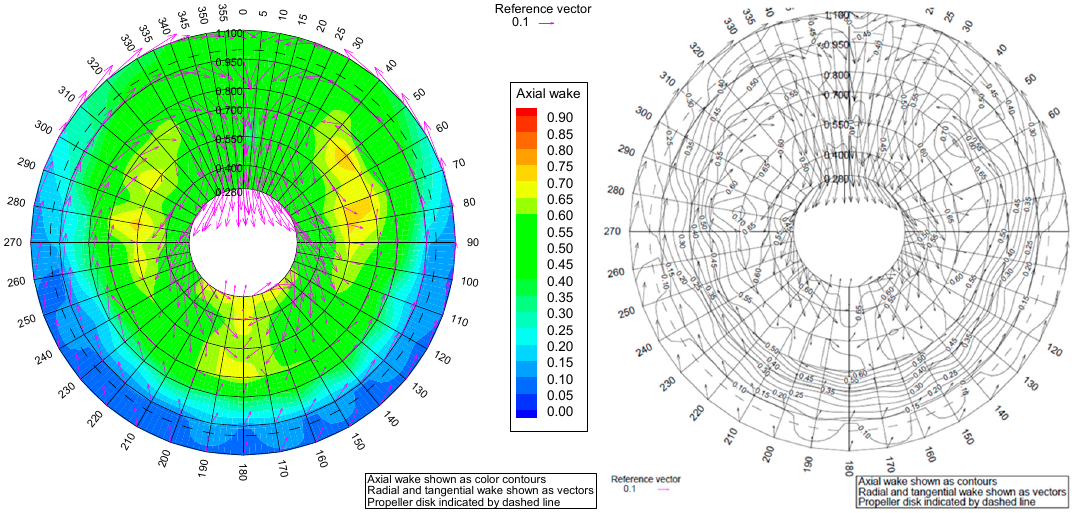
Figure 18. Wave profile during the resistance test with PSS at 14 kn.